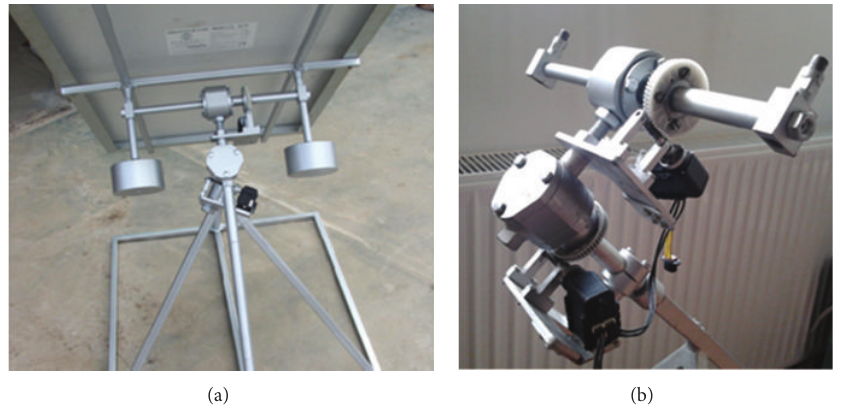
Figure 15: The physical prototype of the equatorial tracking system.